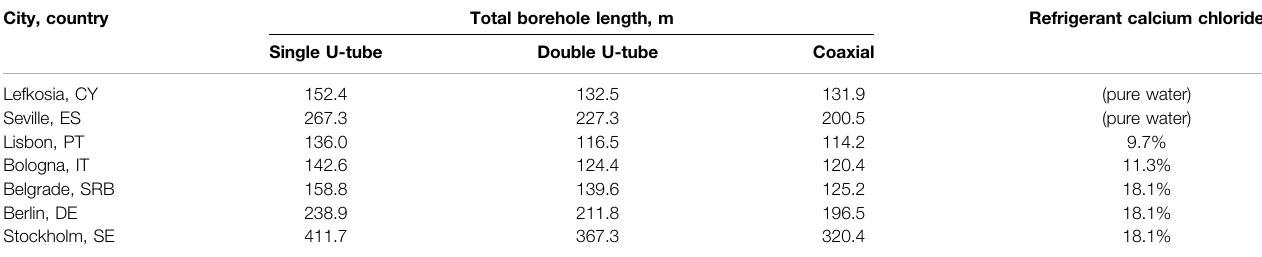
TABLE 3 | Total borehole length with different GHE con fi gurations and different rate of antifreeze solution at each city, estimated using the GLD software. City,